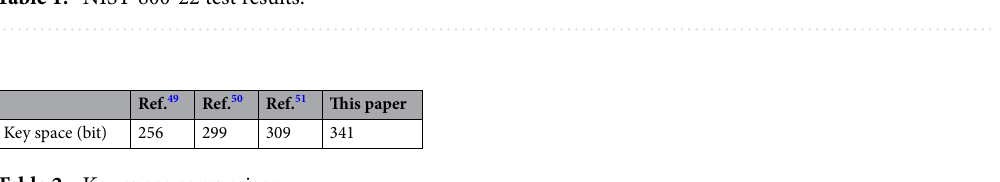
Table 2. Key space